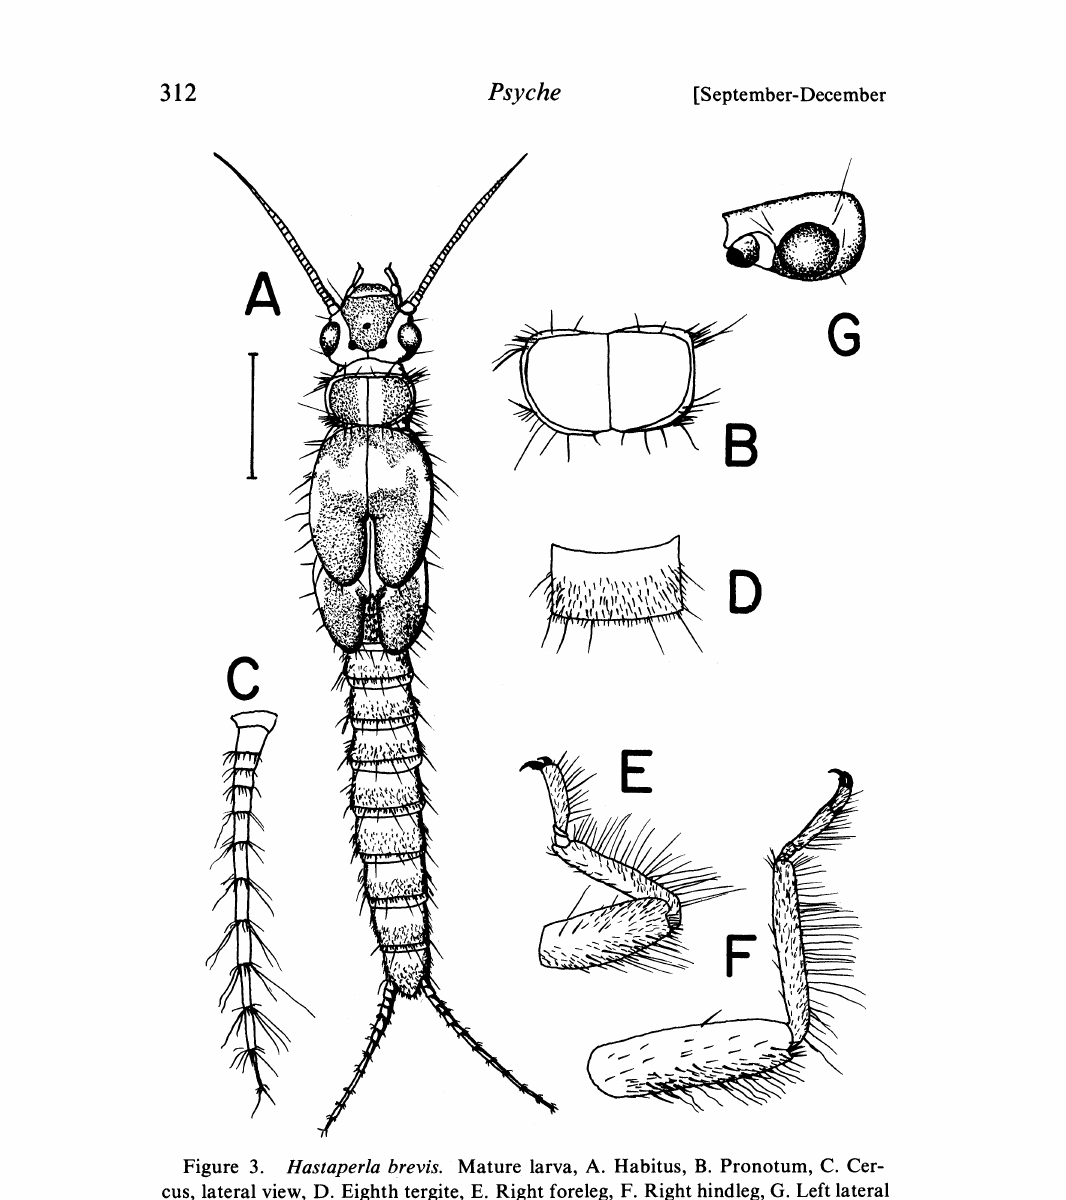
Figure 3. Hastaperla brevis. Mature larva, A. Habitus, B. Pronotum, C. Cer- cus, lateral view, D. Eighth tergite, E. Right foreleg, F. Right hindleg, G. Left lateral view of head. New Hampshire, Grafton Co., W. Thornton, Hubbard Brook, 5 June, 1975, S. B.